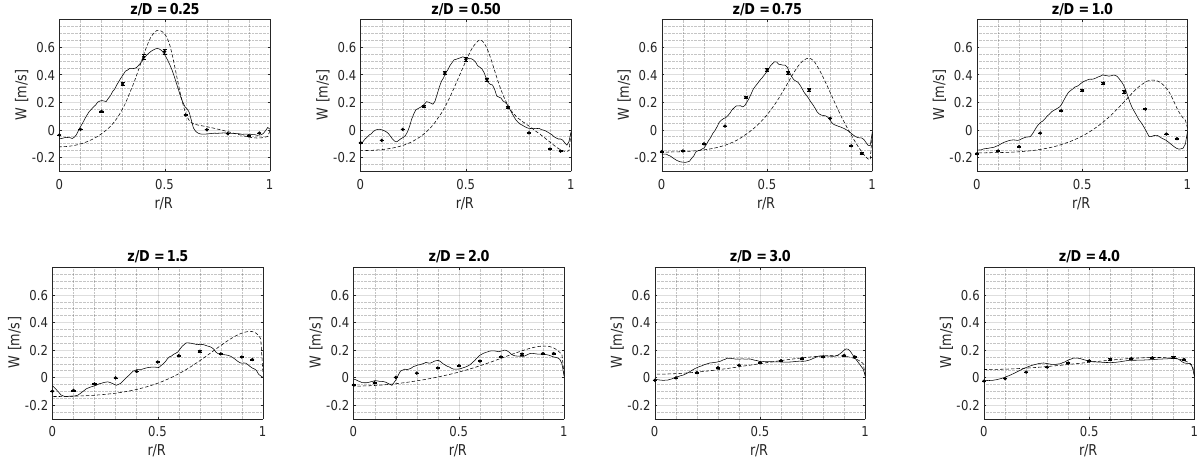
Figure 9. Mean axial velocity at several cross sections (dashed line: k- ω Shear Stress Transport (SST) Reynolds-averaged Navier–Stokes (RANS), solid line: Wall-Adapting Local Eddy-viscosity (WALE) large-eddy simulation (LES), dots: experi- ments).